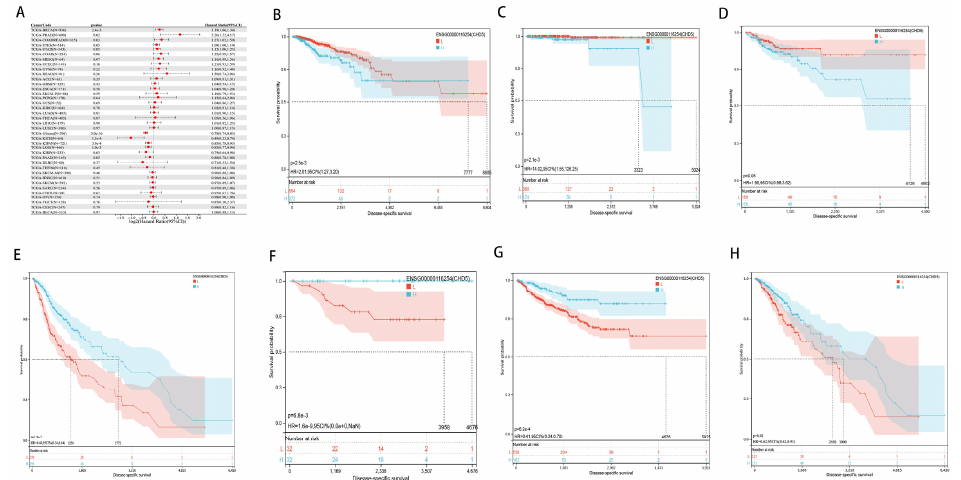
Figure A1. Correlation between CHD5 expression and disease ‐ specific survival (DSS). ( A ) Forest plots showing correlations between DSS and CHD5 expression in 44 tumor types. Kaplan ‐ Meier analyses of the association between CHD5 expression and DSS in ( B ) Breast invasive carcinoma (BRCA), ( C ) prostate cancer (PRAD), ( D ) Colon adenocarcinoma/Rectum adenocarcinoma Esophageal carcinoma (COADREAD), ( E ) Glioma, ( F ) Kidney Chromophobe (KICH), ( G ) Pan ‐ kidney cohort (KICH+KIRC+KIRP) (KIPAN), ( H ) low grade glioma (LGG).